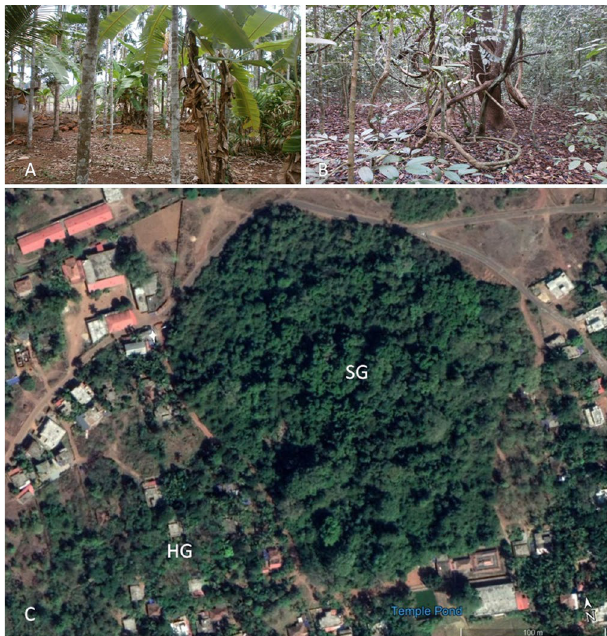
Figure 2. ( A ) Closer view of a home garden, ( B ) a sacred grove, and ( C ) satellite view of a study site (Cheemeni 1). Photo credits for ( A , B ): G. Asha; for ( C ). Copyright: GOOGLE EARTH